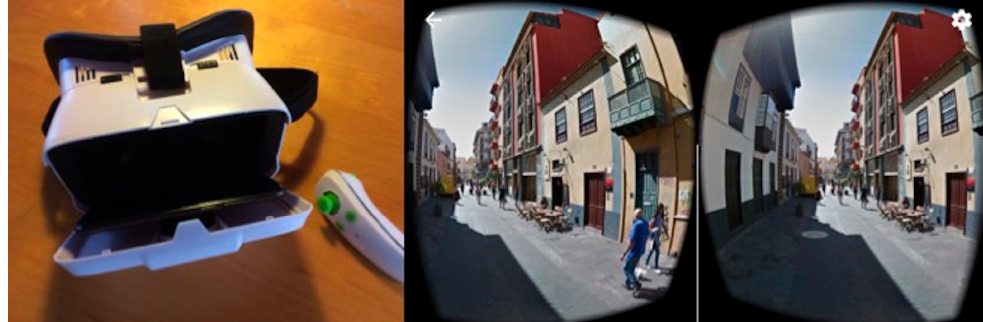
Figure 1. ( Left ): Woxter Neo virtual reality (VR) 3D glasses. Bluetooth remote control with joystick. ( Right ): Virtual urban environment generated.